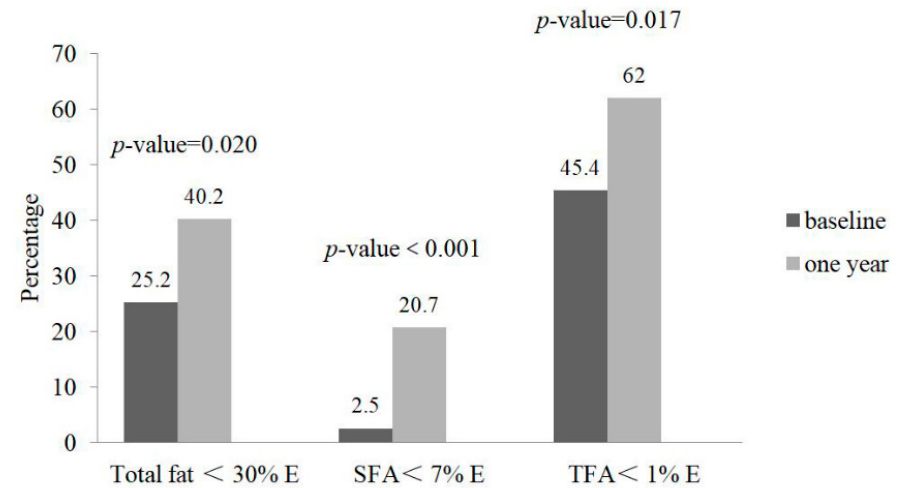
Figure 1. Percentage of participants complying with the AHA dietary intake recommendations for total fat, saturated fatty acid (SFA) and trans fatty acid (TFA) over time.